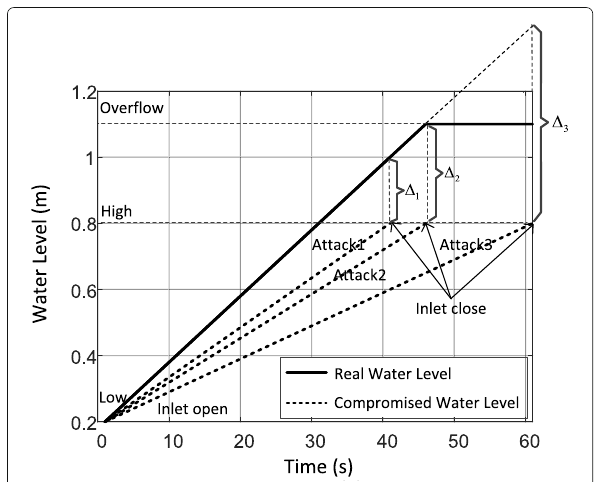
Fig. 3 Different attacks on the water level control system